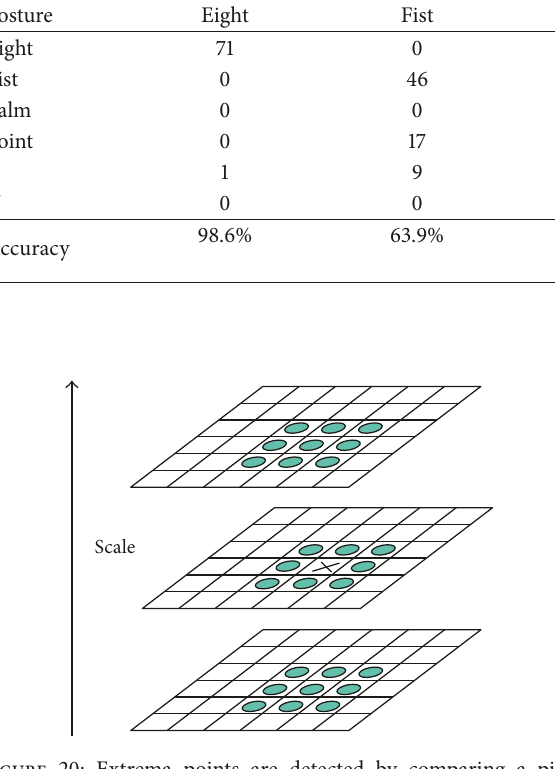
Figure 20: Extrema points are detected by comparing a pixel (marked with × ) to its 26 neighbors (marked with circles) in 3 × 3 regions at the current and adjacent DoGs